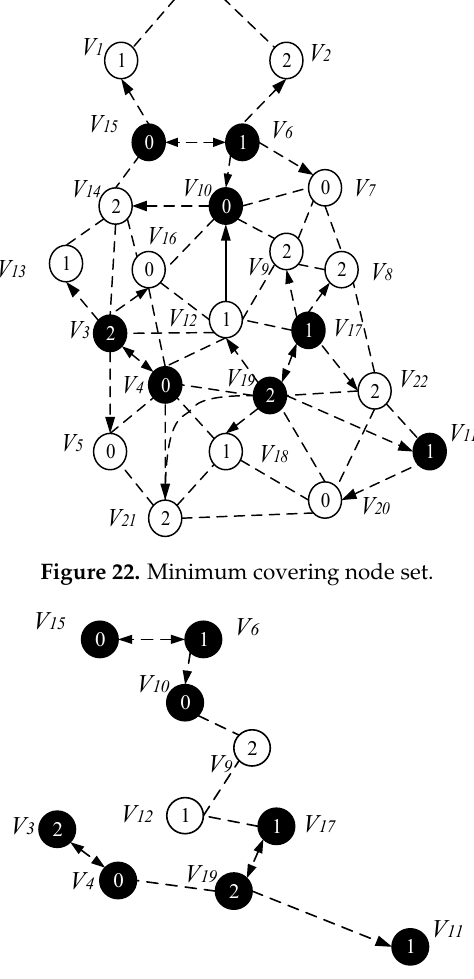
Figure 23. Broadcast backbone for ABRCD.